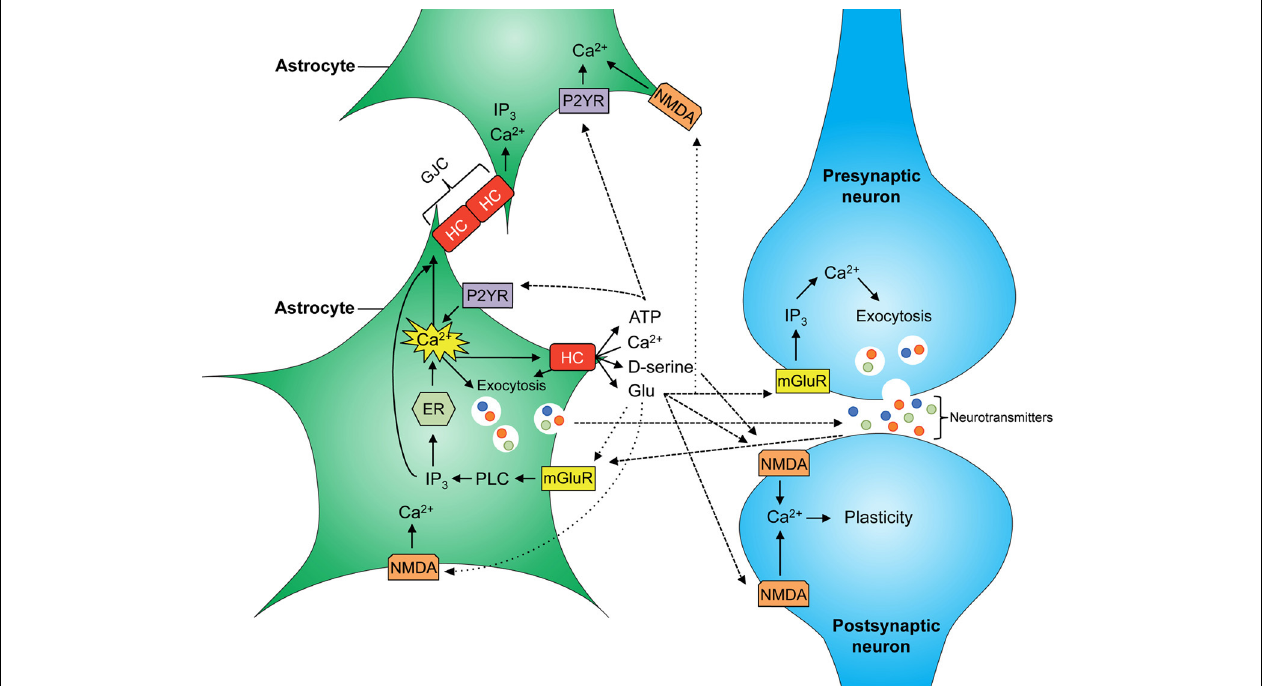
FIGURE 1 | Scheme of major astrocyte signaling associated to gliotransmitter release. Increased intracellular free Ca 2 + concentration ([Ca 2 + ]) i allows the release of gliotransmitters into the synaptic cleft through vesicles and hemichannels (HCs). D-serine, glycine, and glutamate released by astrocytes can activate NMDA receptors at the post-synaptic neuron and modulate neuronal plasticity. Astroglial